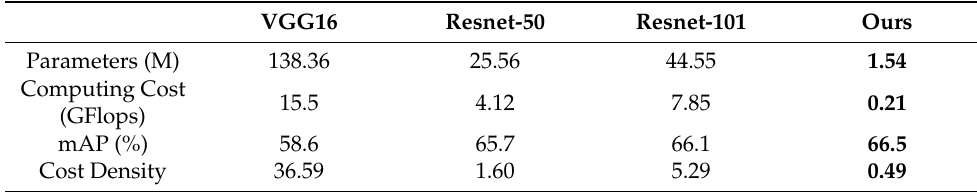
Table 7. Cost comparison of different